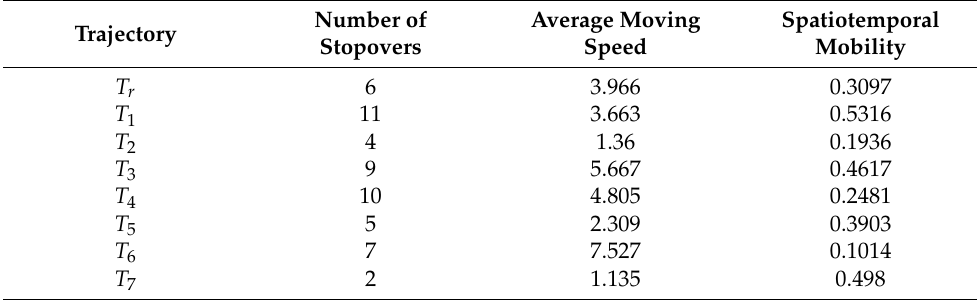
Figure 3. A case study. ( a ) Initial trajectory candidate map. ( b ) Initial trajectory candidate graph. Table 2. Number of stopovers and average moving speed of the initial trajectory